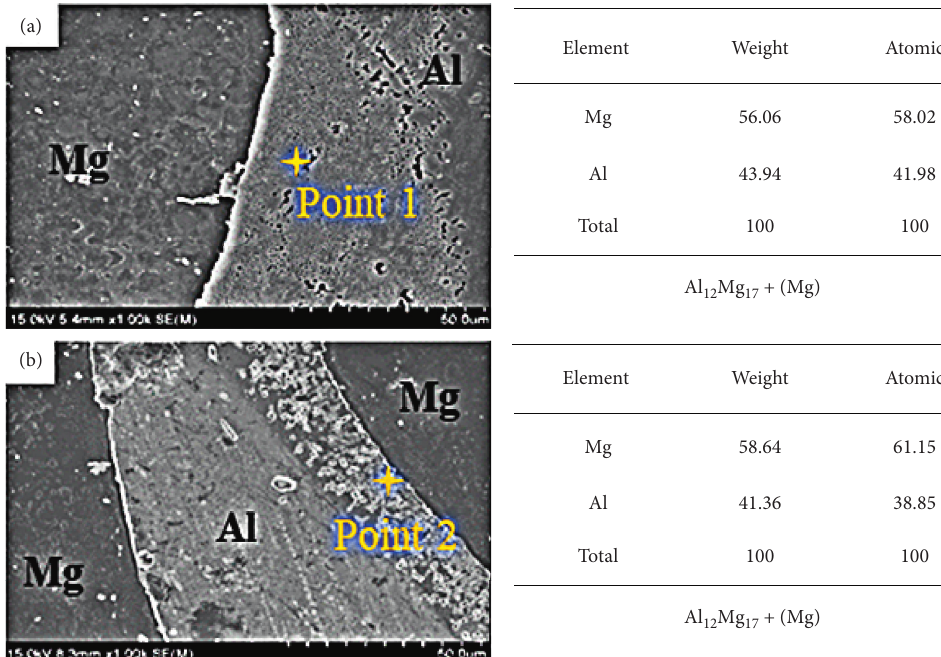
Figure 11: SEM and EDS results of cold lap and hook: (a) enlarged view of the cold lap and (b) enlarged view of the